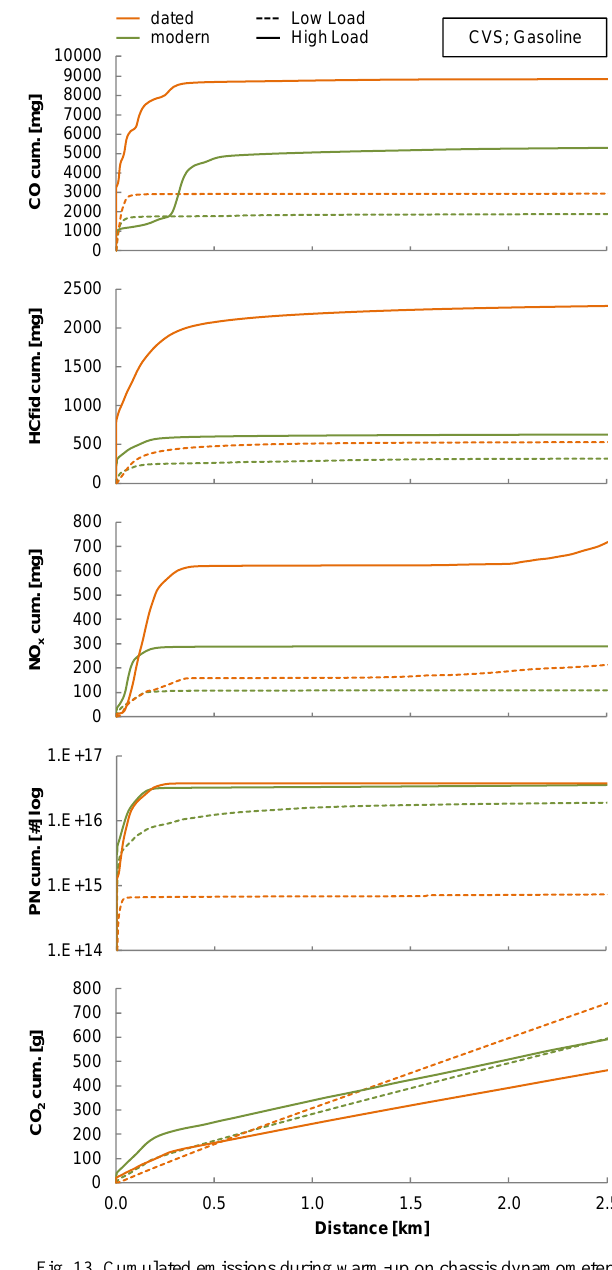
Fig. 13. Cumulated emissions during warm-up on chassis dynamometer with two gasoline vehicles and different loads Several findings have to be mentioned:   the dated vehicle: after 2 km NO starts to increase, x